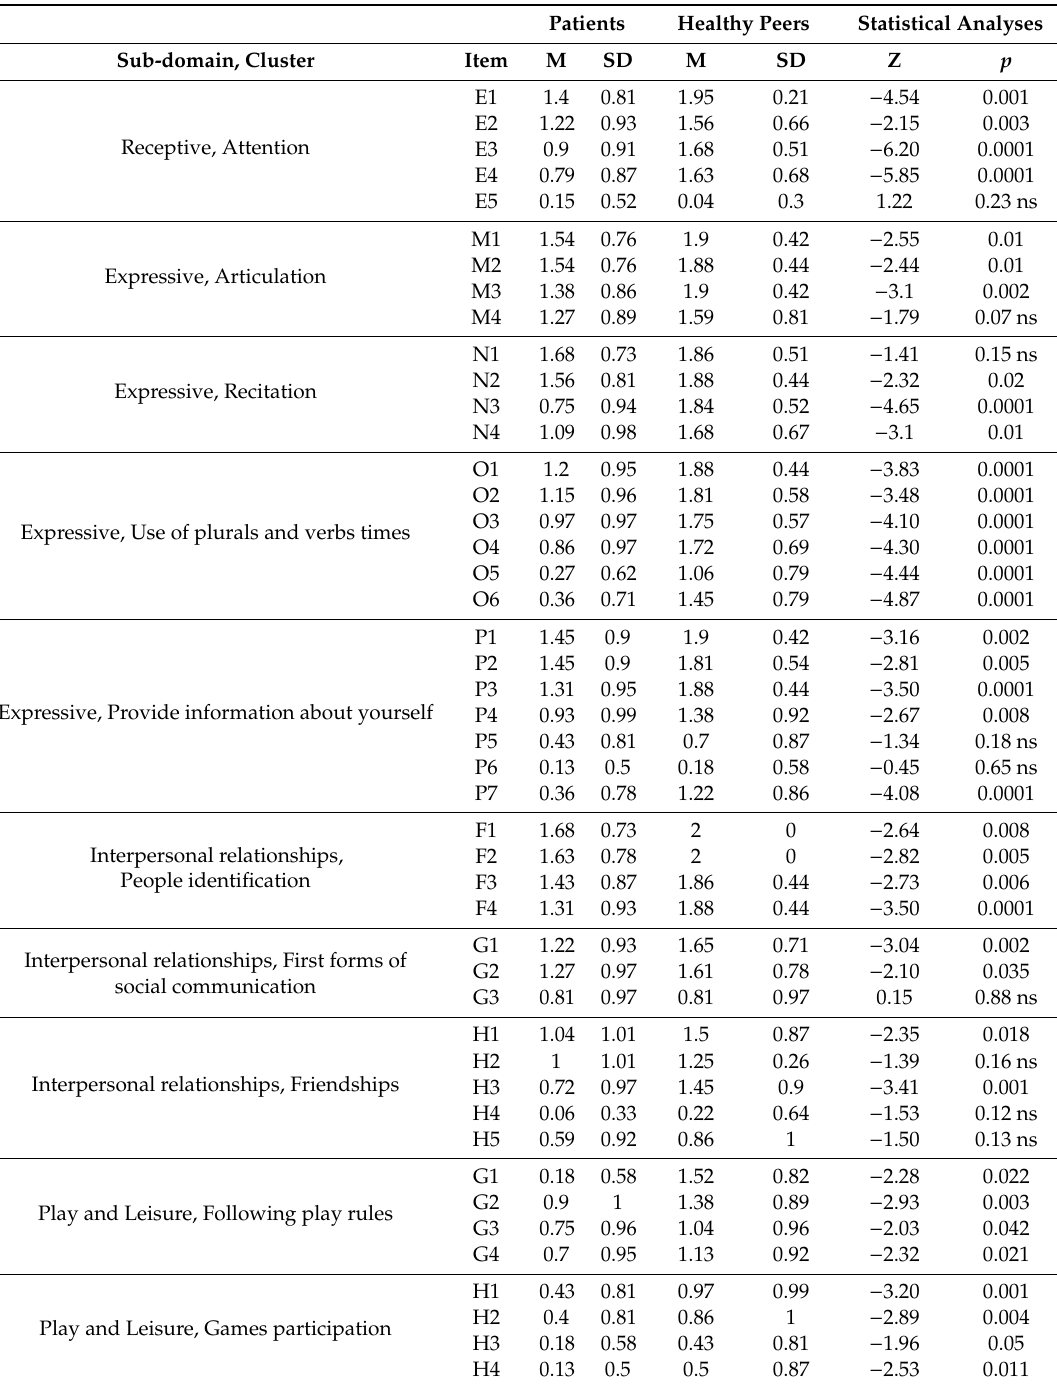
Table 4. Clinic and control group comparisons along VABS items, grouped by cluster belonging to communication and socialization domains (ns stays for not